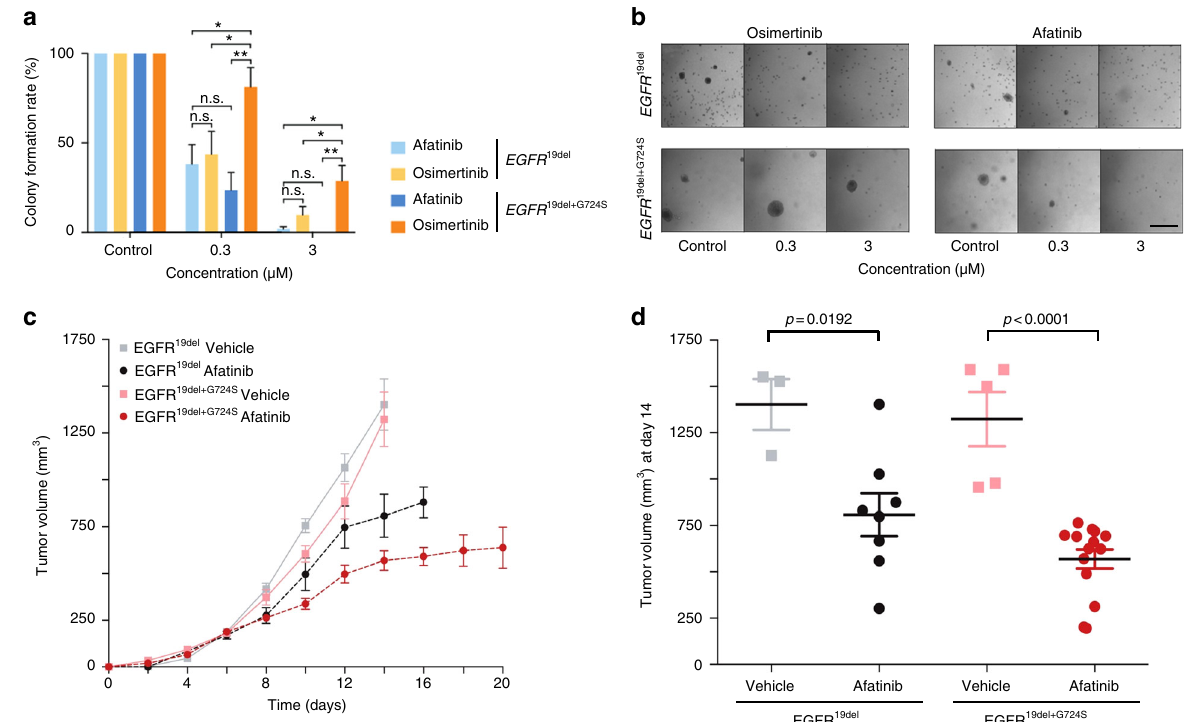
Fig. 6 Sensitivity of EGFR G724S to second-generation EGFR inhibitor in vitro and in vivo. a Relative mean colony number of NIH-3T3 EGFR 19del cells compared with EGFR 19del + G724S cells was assessed in soft agar assays after 16 days under treatment. Cells were treated with osimertinib or afatinib. b Representative images of colonies under treatment are displayed in the lower panel. Scale bars, 50 μ m ( n = 4), n.s.: non-signi fi cant, * = p < 0.05, ** = p < 0.01. c , d Graphs show tumor volume in mice injected with NIH-3T3 EGFR 19del and EGFR 19del + G724S cells treated with afatinib (20 mg/kg, p.o., once daily). c Tumor volumes ( EGFR 19del vehicle, n = 13 mice; EGFR 19del osimertinib, n = 8 mice; EGFR 19del + G724S vehicle, n = 11 mice; EGFR 19del + G724S osimertinib, n = 14 mice) were assessed for 20 days by longitudinal caliper measurements every second day following treatment initiation. d Tumor volumes were quanti fi ed after 8 days of treatment. Volume changes in the afatinib treatment cohort (dark gray and red) were compared with the vehicle- treated control group (light gray and light red). Each dot represents one tumor from a mouse. Signi fi cance is indicated by asterisk and calculated by